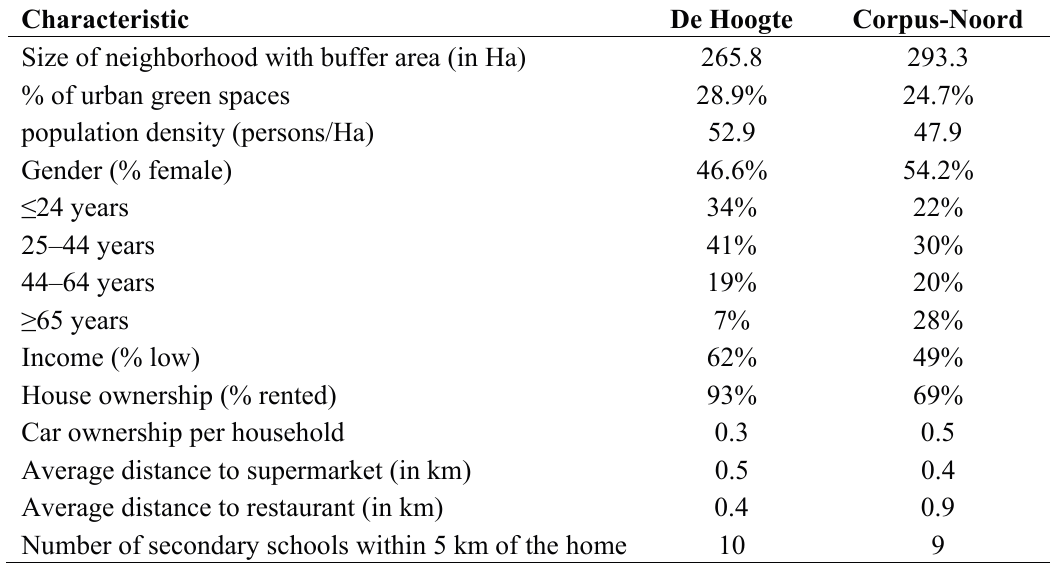
Table 1. Characteristics of the two neighborhoods calculated from GIS and census data [59].